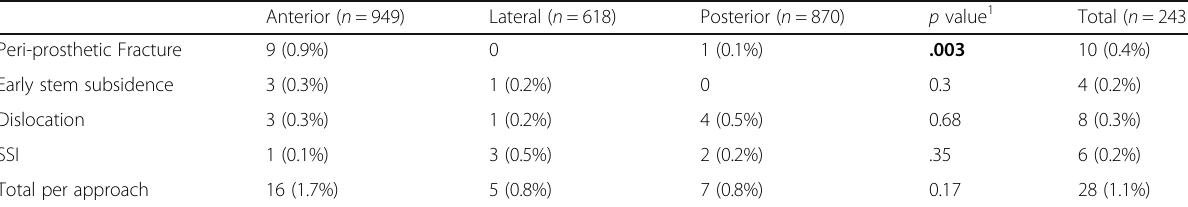
Table 2 Revision rates within